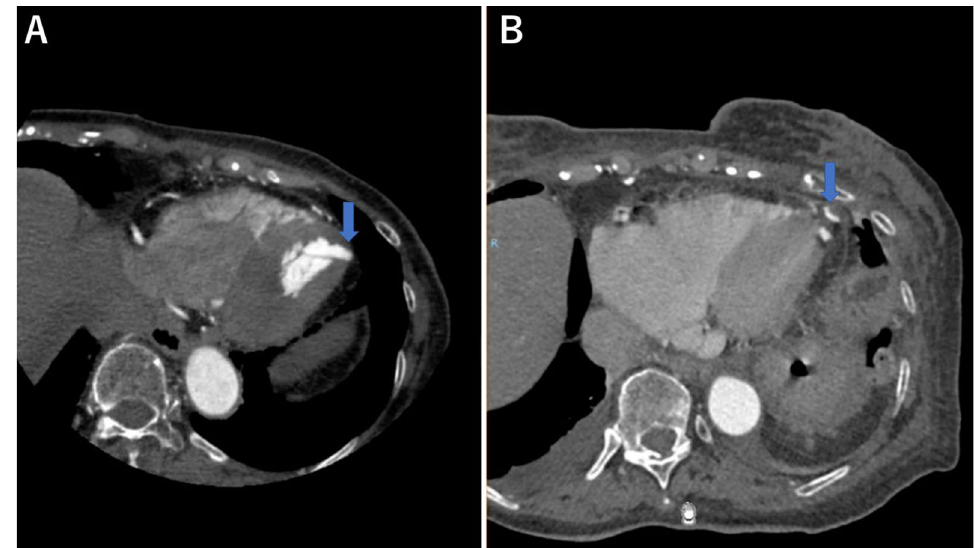
Fig. 1 Pre- and postoperative CT scan images. a Preoperative CT scan images. Allows: left ventricle aneurysm. b Postoperative CT scan images. CT computed tomography